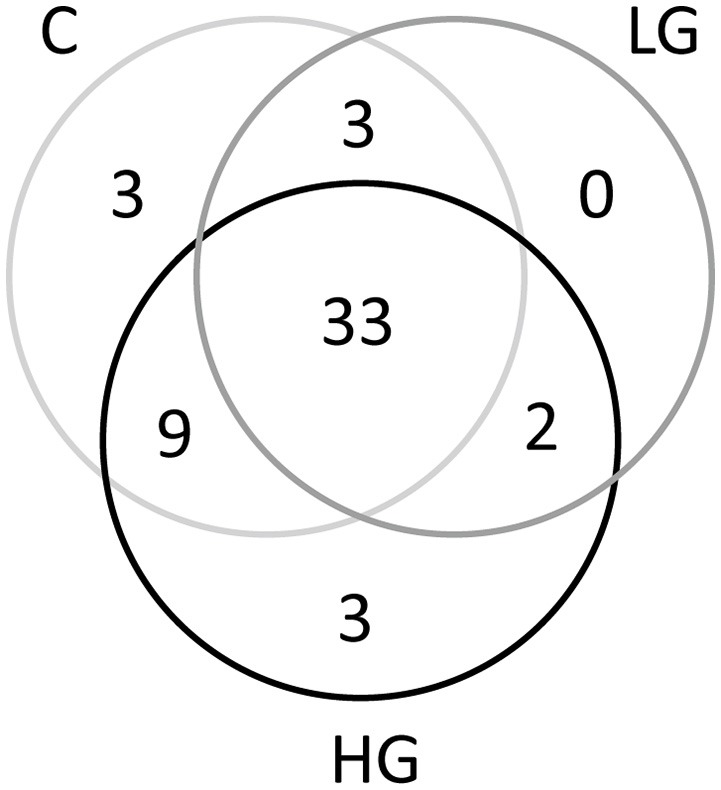
Venn diagrams (at distance 0.03) showing the shared as well as specific phylotypes in groups C, LG, and HG.